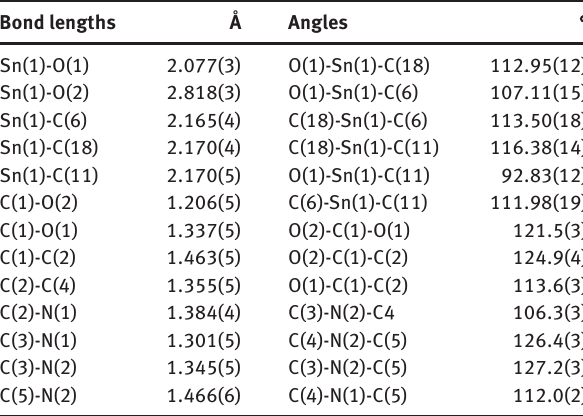
Table 1: Selected bond lengths (Å) and angles ( ° ) for complex 1